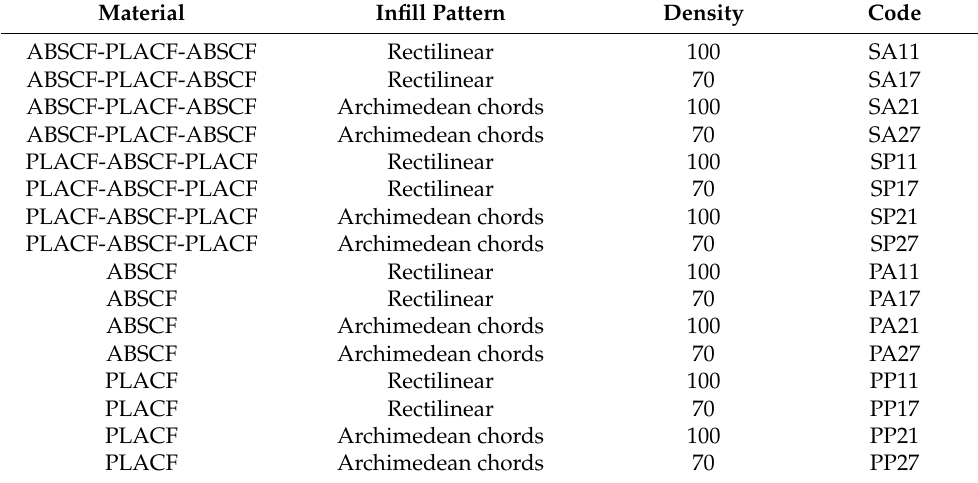
Table 3. Sample codes.